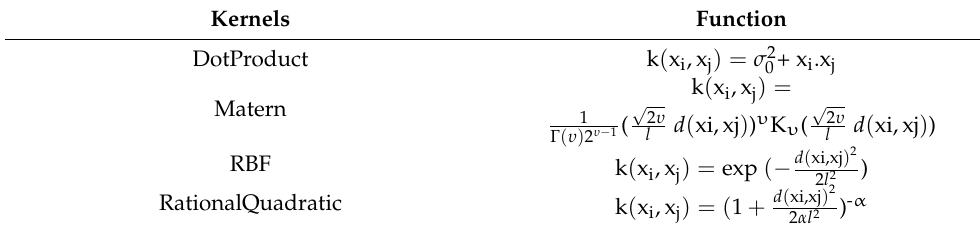
Table 1. Gaussian process kernels with related functions.